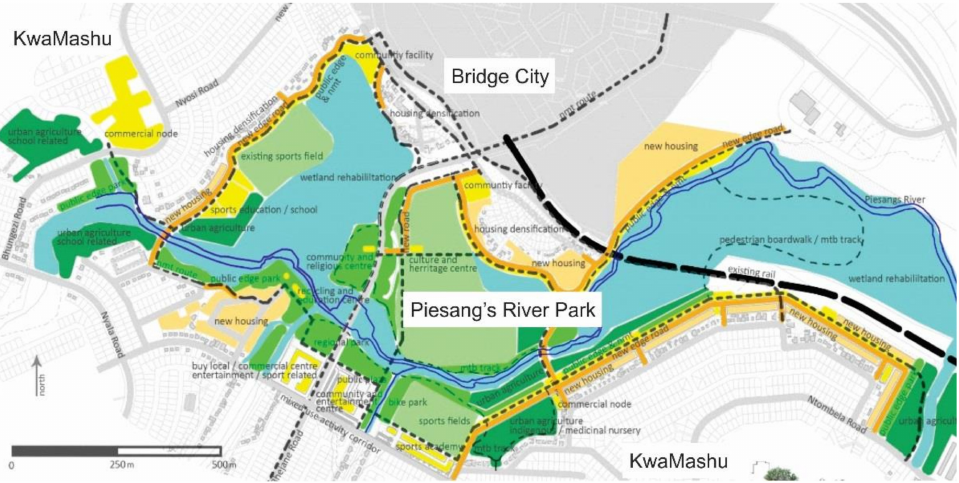
Figure 4. The Spatial Framework Plan for the proposed Piesang’s River Park. Pedestrian connections are essential for the functioning of the system. Source: